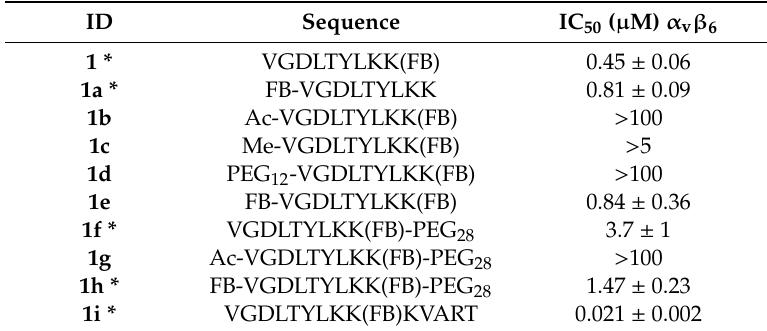
Table 2. ELISA data showing the relative binding a ffi nity of derivatives of 1 to integrin α v β 6 measured by IC 50 values ( n = 3).